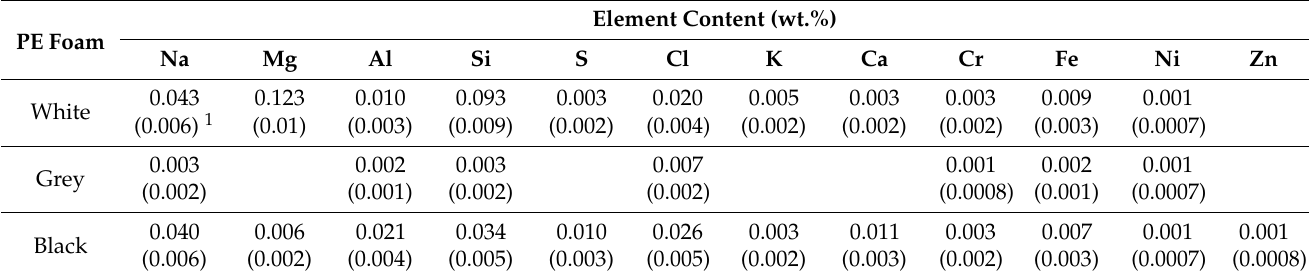
Table 1. Results of XRF analyses for PE foams.